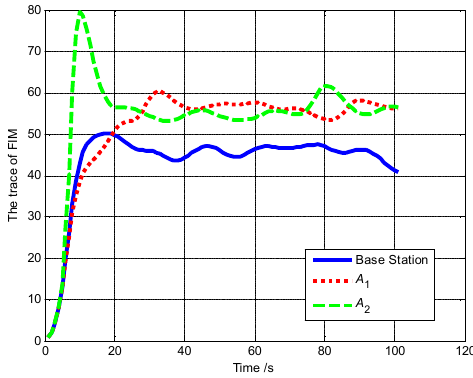
Figure 15. The probabilities of successful transmission of A 1 and A 2 to base station (Group B in Scenario 1).